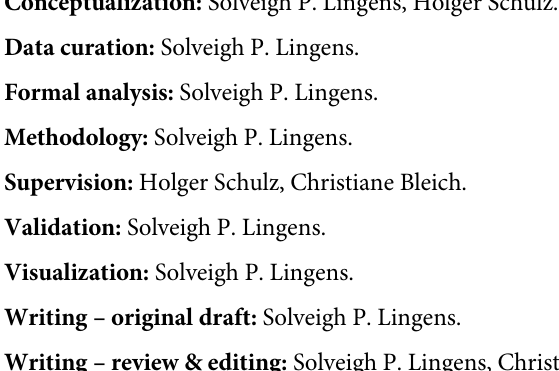
S1 Table. Full search history